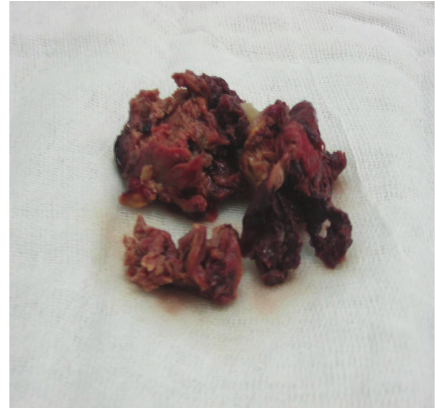
Figure 5: Surgery findings: left atrial mass which seems to be friable and